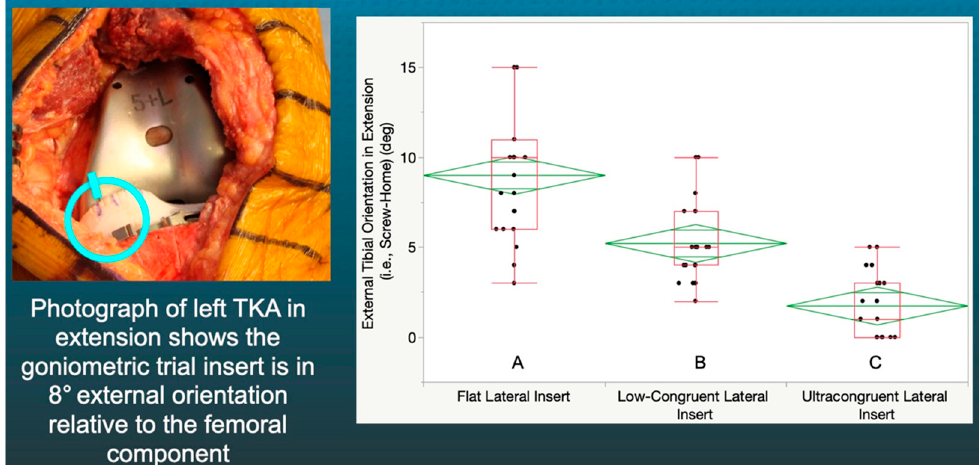
Figure 3. Box plot showing external tibial orientation in flexion for the three insert congruencies. Congruencies not connected by the same letters were significantly different.